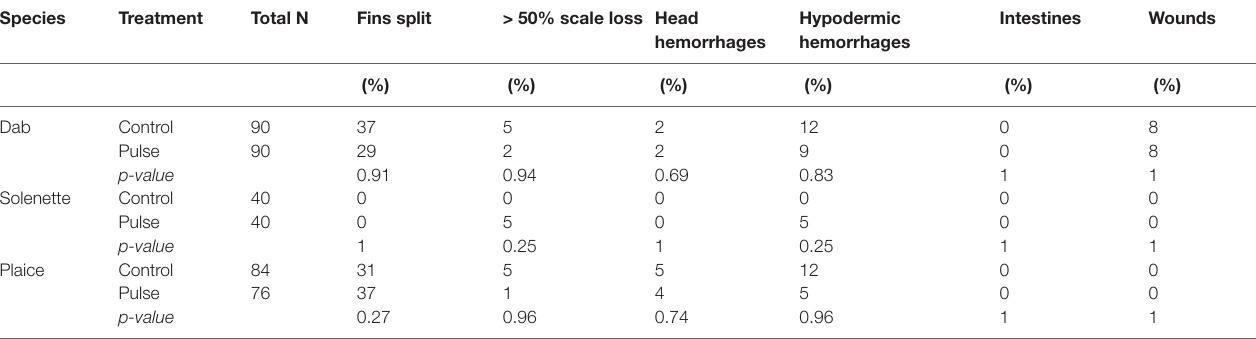
TABLE 6 | Presence of damages (response = 1, % of total number of observations, N) in dab, solenette and plaice sampled from pulse trawl tracks (Pulse) and unfished control areas (Control). Species Treatment